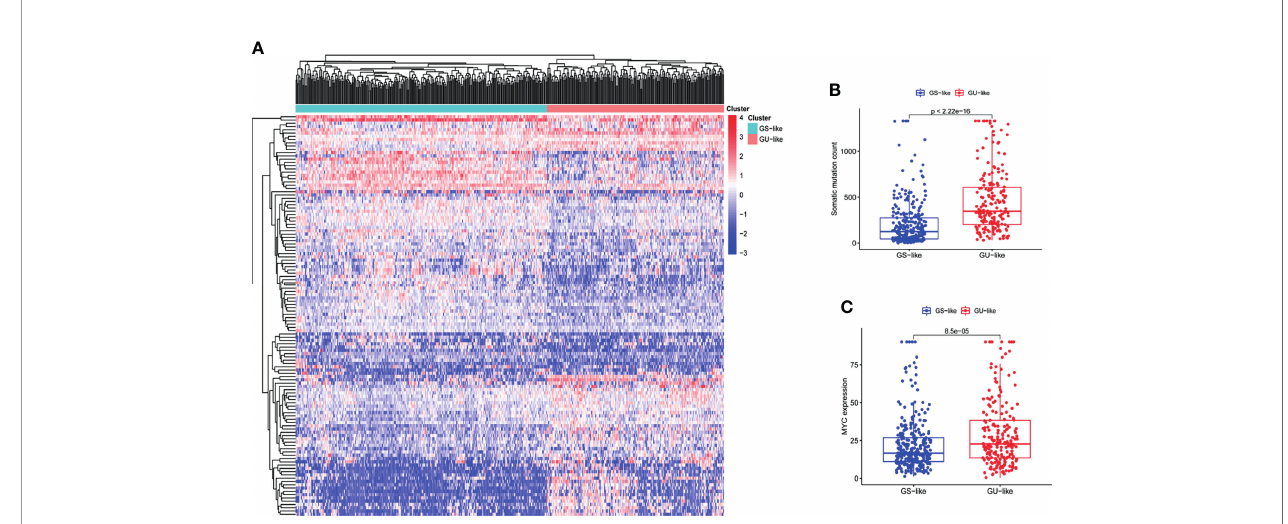
FIGURE 1 | The recognition of genomic instability-associated lncRNAs in patients with LUAD. (A) On the basis of the expression patterns of 123 candidate lncRNAs associated with genomic instability, unsupervised clustering was performed in 497 LUAD patients. The blue cluster on the left represents the GS-like group, the red cluster on the right represents the GU-like group. (B) Boxplots of somatic mutations in the GS-like group and GU-like group. The accumulative mutation count of somatic cells in the GS-like group is dramatically lower than that in the GU-like group. (C) Boxplots of MYC expression level in the GS-like group and GU-like group. The expression level of MYC in the GS-like group is dramatically lower than that in the GS-like